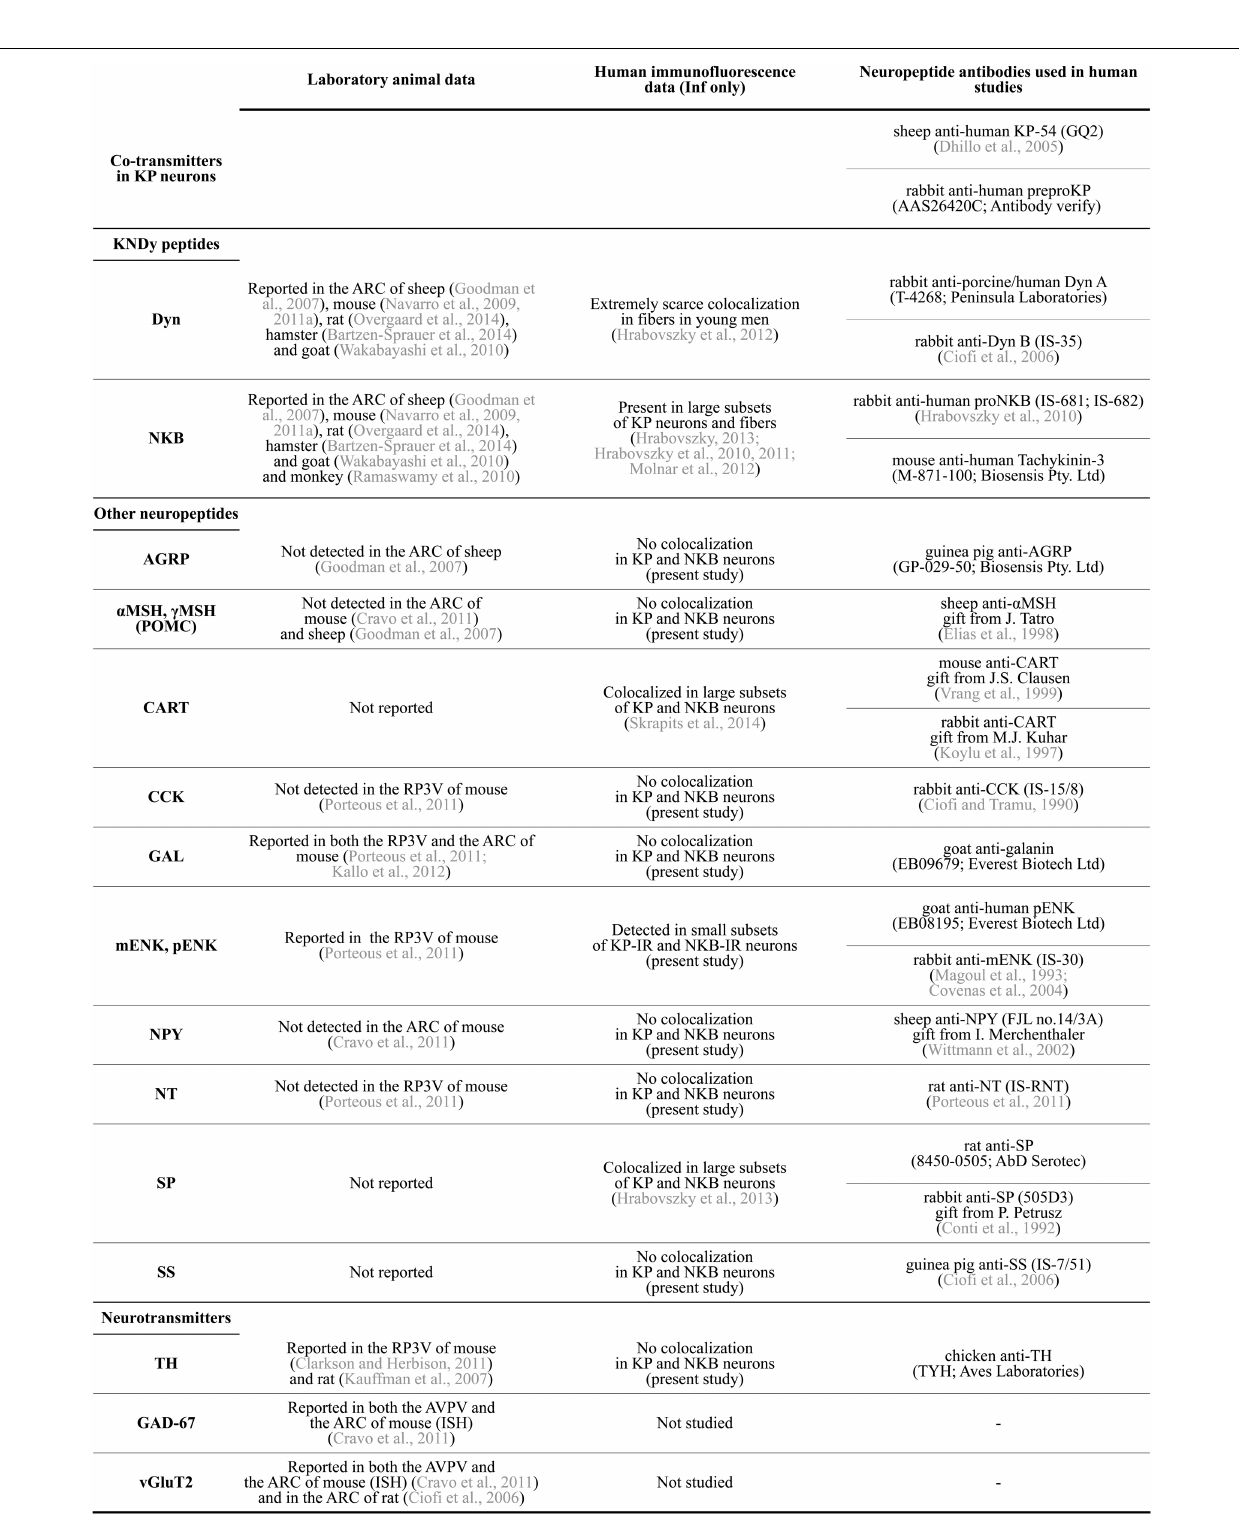
infundibular nucleus; ISH, in situ hybridization; KP, kisspeptin; mENK, met-enkephalin; NKB, neurokinin B; NPY, neuropeptide Y; NT, neurotensin; pENK, proenkephalin; POMC, proopiomelanocortin; RP3V, rostral periventricular area of the third ventricle; SP, substance P; SS, somatostatin; TH, tyrosine hydroxylase; vGluT2, type-2 vesicular glutamate